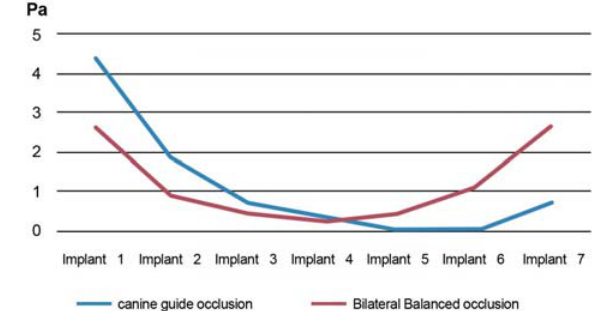
Figure 5- Values of the equivalent stress found in the implants